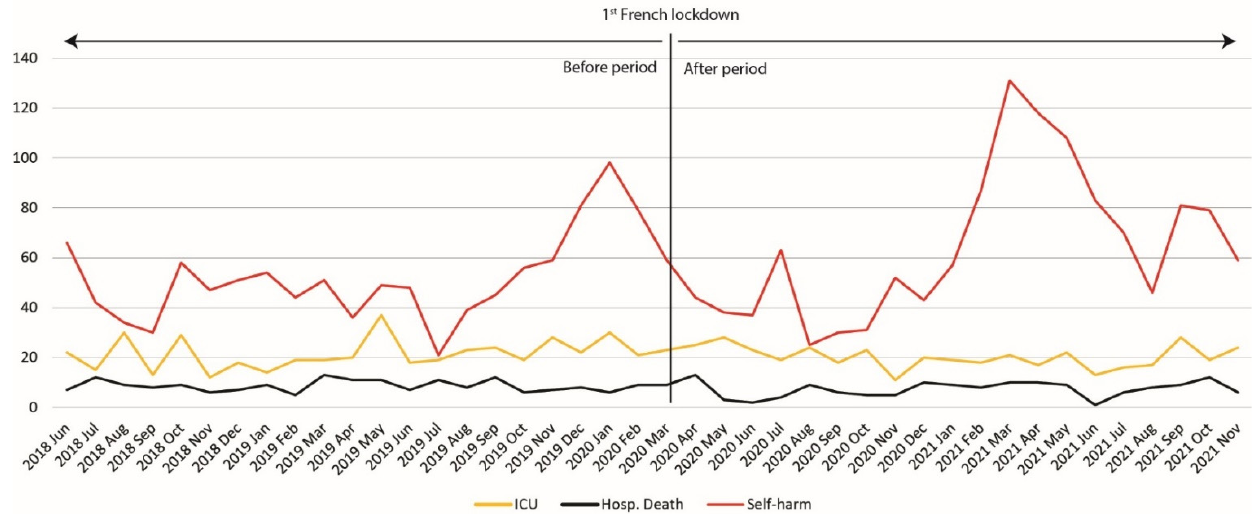
Figure 2. Monthly number of hospitalizations for patients with anorexia nervosa with an associated code for self-harm, admission to an intensive care unit or with hospital death from June 2018 to November 2021.